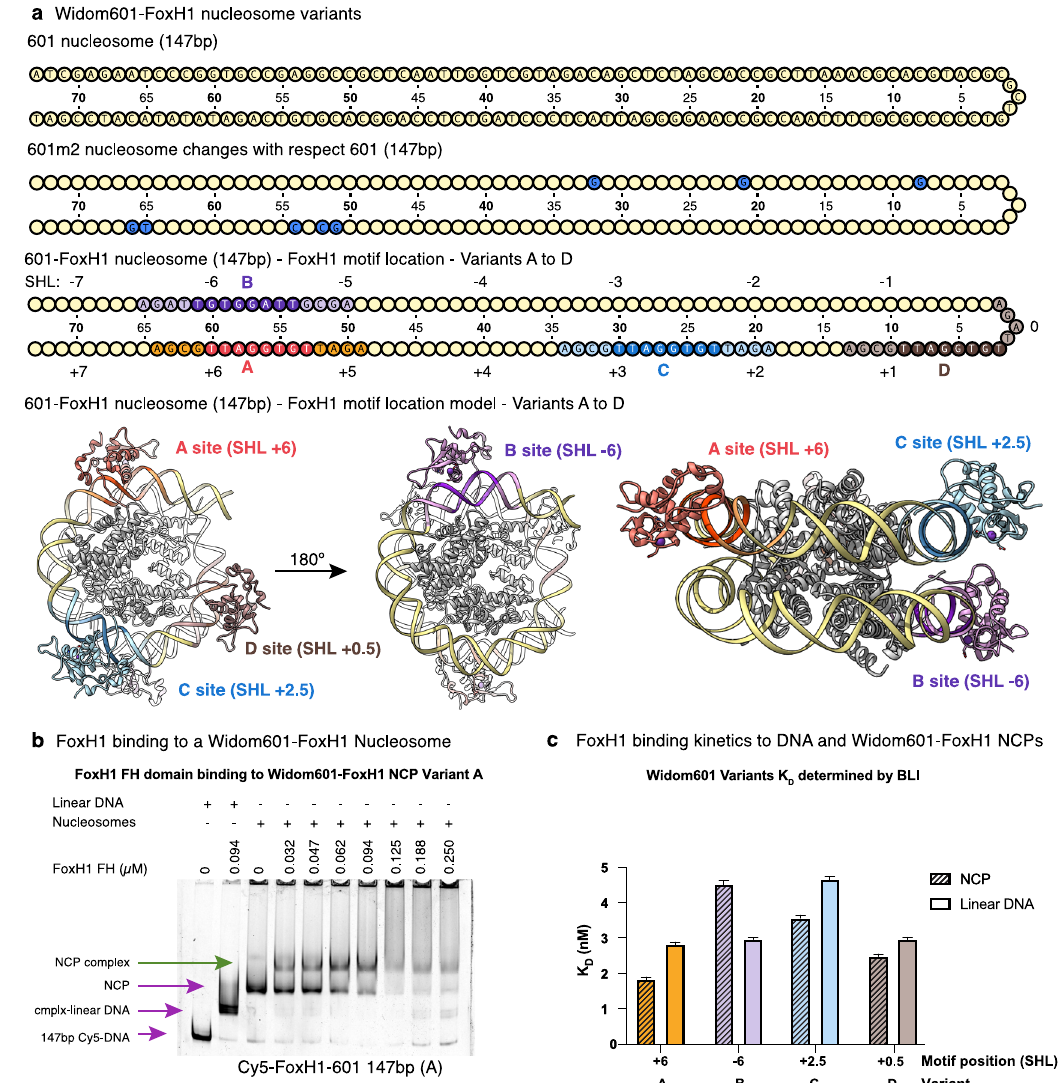
Fig. 6 | FoxH1 binding to reconstituted mononucleosomes. a Schematic repre- sentationofthe601147-NCPWTandvariantsusedinthiswork.TheWTsequenceis shownonthe top and themodi fi cationsintroduced inthevariantsarehighlighted. Changesinthem2sequencewereintroducedtoremoveFoxH1pseudo-motifs.A – D variants represent the different positions of the FoxH1 speci fi c motif explored in thiswork. A model ofa nucleosome (basedon PDB:5oxv) with FoxH1bound to the A-D variants is shown in three different views. b Titration of the Widom601-FoxH1